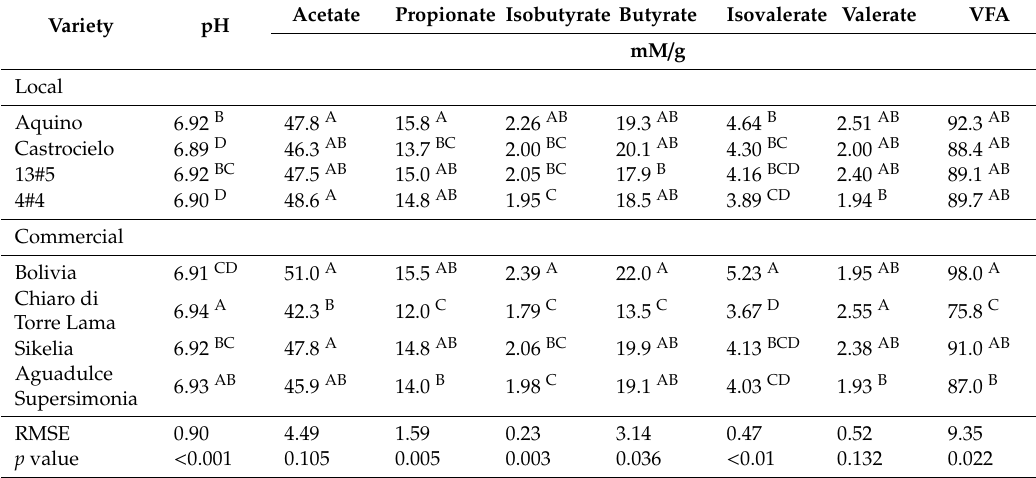
Table 4. pH values and concentration of volatile fatty acids after 48 h of in vitro incubation.